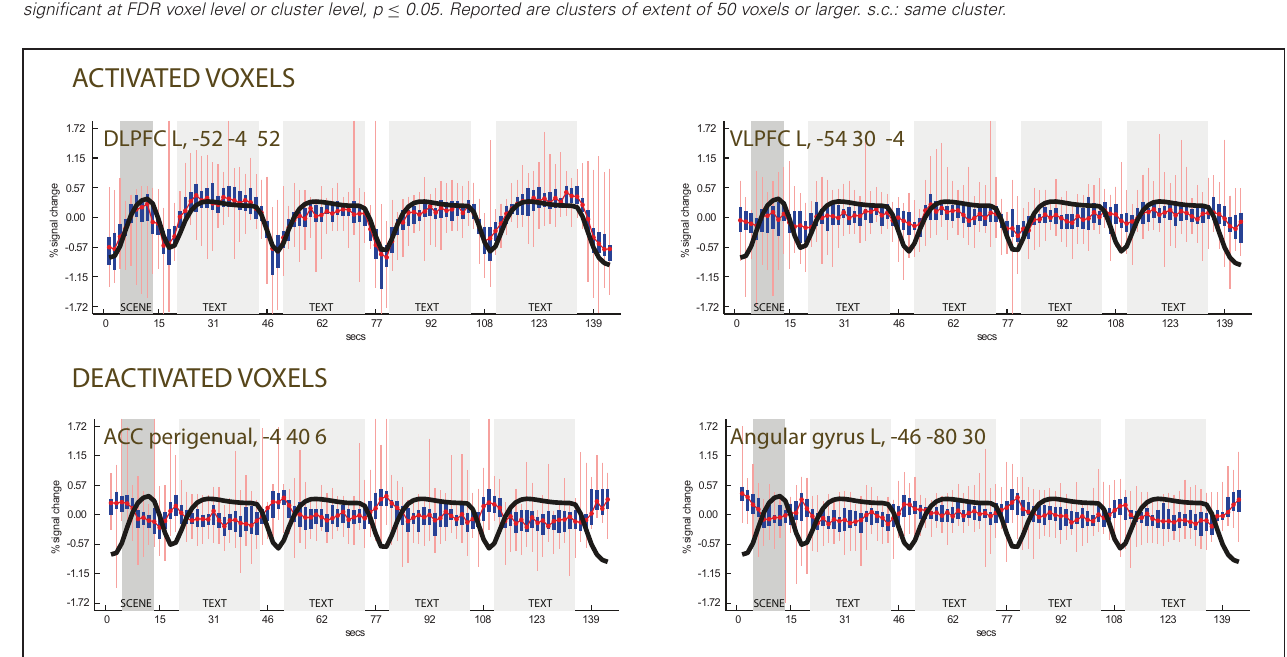
presentation of the scene (in dark gray background) and the textual descriptions (light gray background). The white background corresponds to the fixation point. The red line is the median signal. Thick blue lines show variation intervals at the 25th and 75th percentile of the data. Light red lines show the same variation at the 2.5th and 97.5th